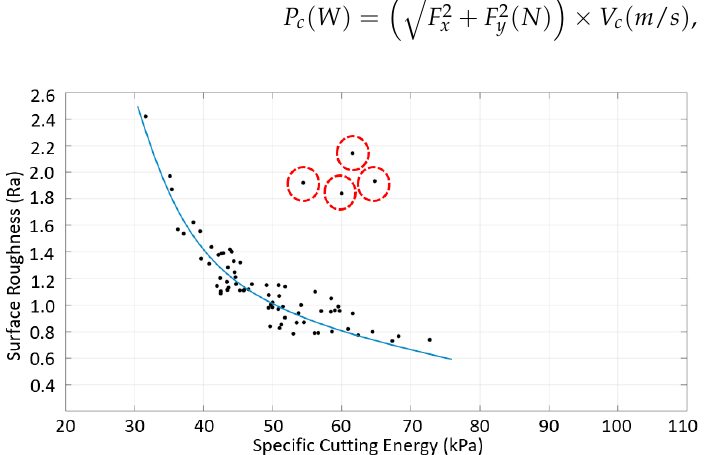
Figure 17. Surface roughness vs. specific cutting energy for the down ‐ milling of SS (red circles indicate outliers).